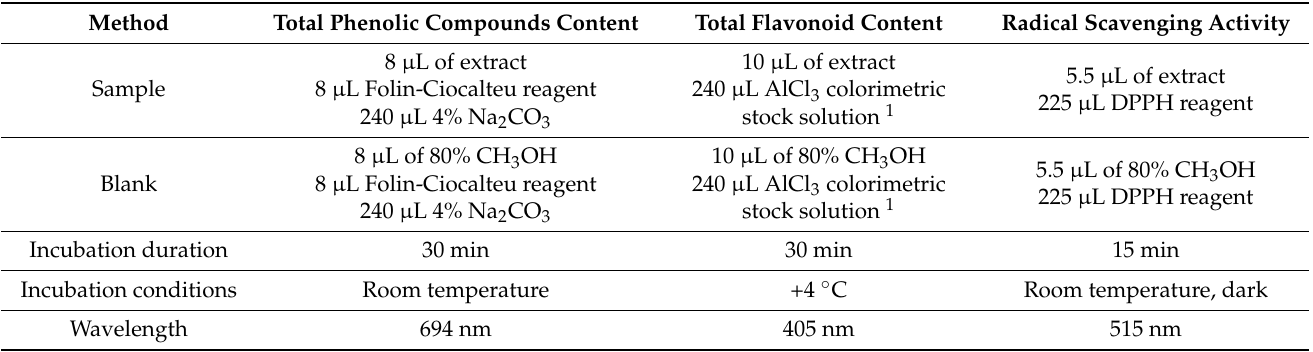
Table 2. Summary of spectrophotometric methods used for pollen samples evaluation.